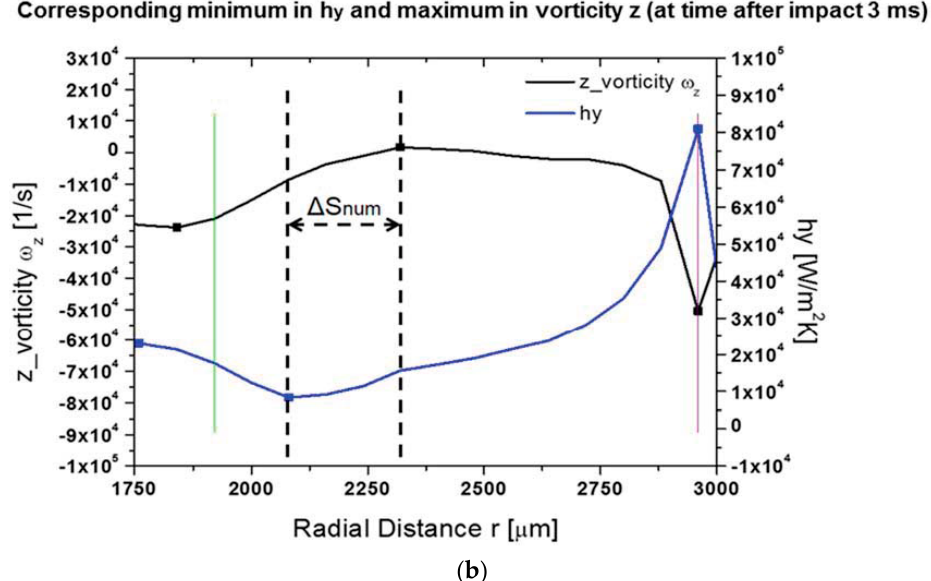
Figure 13. ( a ) Schematic view of the rim region and representation of the parameters chosen for the final formulation of the theoretical spatial shift between local maxima and minima of heat transfer coefficient and vorticity. The bright grey area represents the fluid domain and the dark grey area the solid domain; ( b ) Corresponding local minimum in heat transfer coefficient and local maximum in vorticity for which the theoretical shift is calculated.